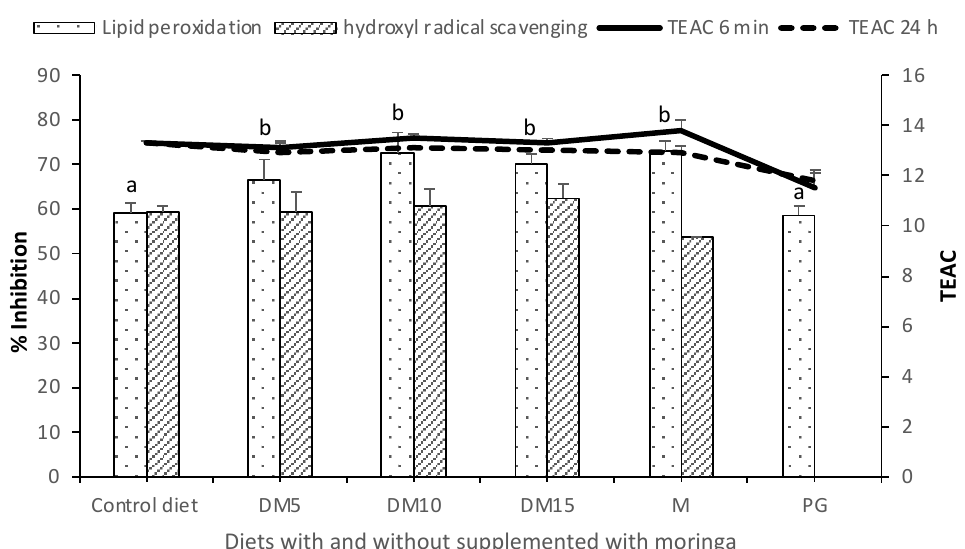
Figure 1. Antioxidant activity of different diets (diet base: non-supplemented diet; 5%, diet supple- mented with 5 g/100 g of Moringa oleifera (MO); 10%, diet supplemented with 10 g/100 g of MO); and 15%, diet supplemented with 15 g/100 g of MO) and MO leaves compared with common food additive antioxidant, propyl gallate (PG) evaluated by different assays—hydroxyl radical scavenging, lipid peroxidation and TEAC. All determinations were performed in triplicate and the columns represent the mean ± standard deviation. Values are expressed as percentage of scavenging of peroxidation lipid and of the hydroxyl radicals and TEAC value. Control diet, commercial diet; DM5, diet with 5% MO; DM10, diet with 10% MO; DM15, diet with 15% MO; M, MO leaves; PG, propyl gallate. TEAC is the micromolar concentration of a Trolox solution showing the antioxidant capacity equivalent to the dilution of the substance under investigation at 6 min and 24 h. Different superscript letters indicate significant differences (ANOVA, p < 0.05).